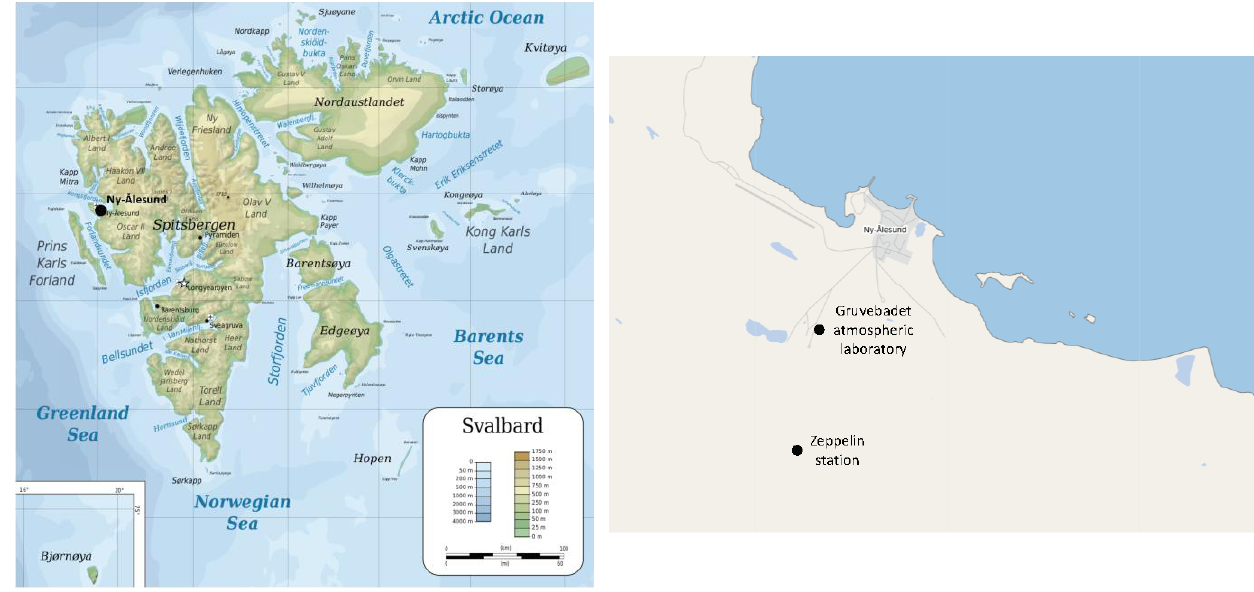
Figure 1. Map of Svalbard Islands on the left. The Gruvebadet atmospheric laboratory (GVB) is located ca. 1 km far from the Ny-Ålesund village (on the right [46]).